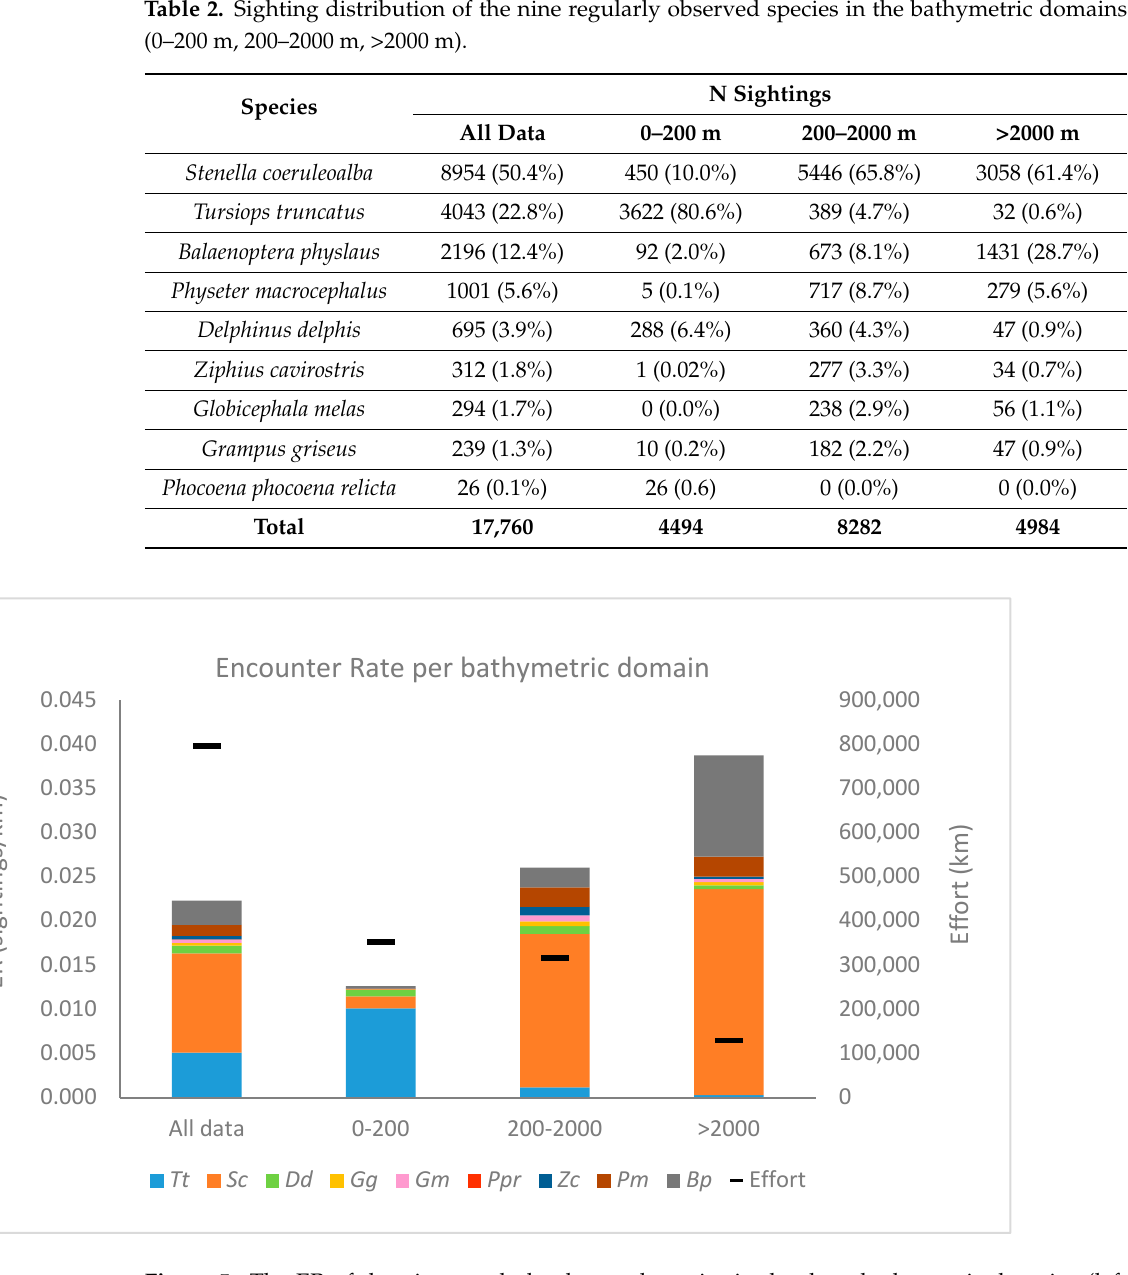
Figure 5. The ER of the nine regularly observed species in the three bathymetric domains (left axis) and the sampling effort (black bars, right axis). Tt : Tursiops truncatus ; Sc : Stenella coeruleoalba ; Dd : Delphinus delphis; Gg: Grampus griseus ; Gm : Globicephala melas ; Ppr : Phocoena phocoena relicta ; Zc : Ziphius cavirostris ; Pm : Physeter macrocephalus ; Bp : Balaenoptera physalus .